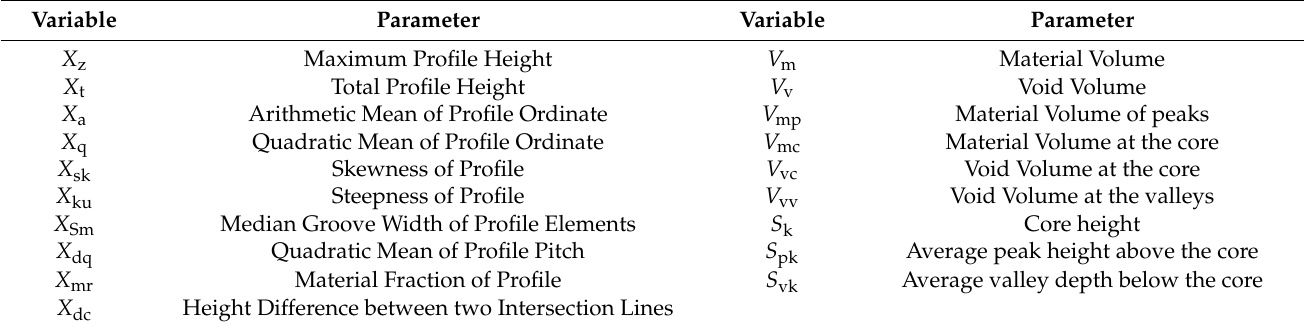
Table 3. Characteristic surface